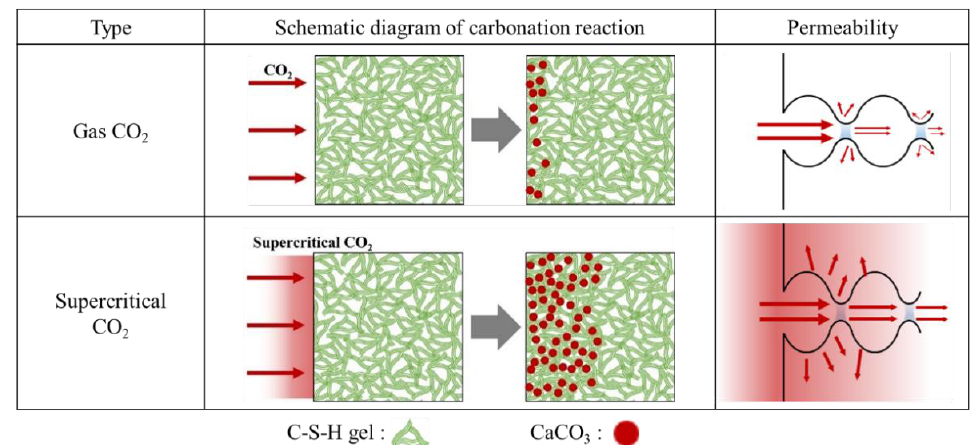
Figure 7. Comparison between accelerated carbonation and supercritical CO 2 curing.